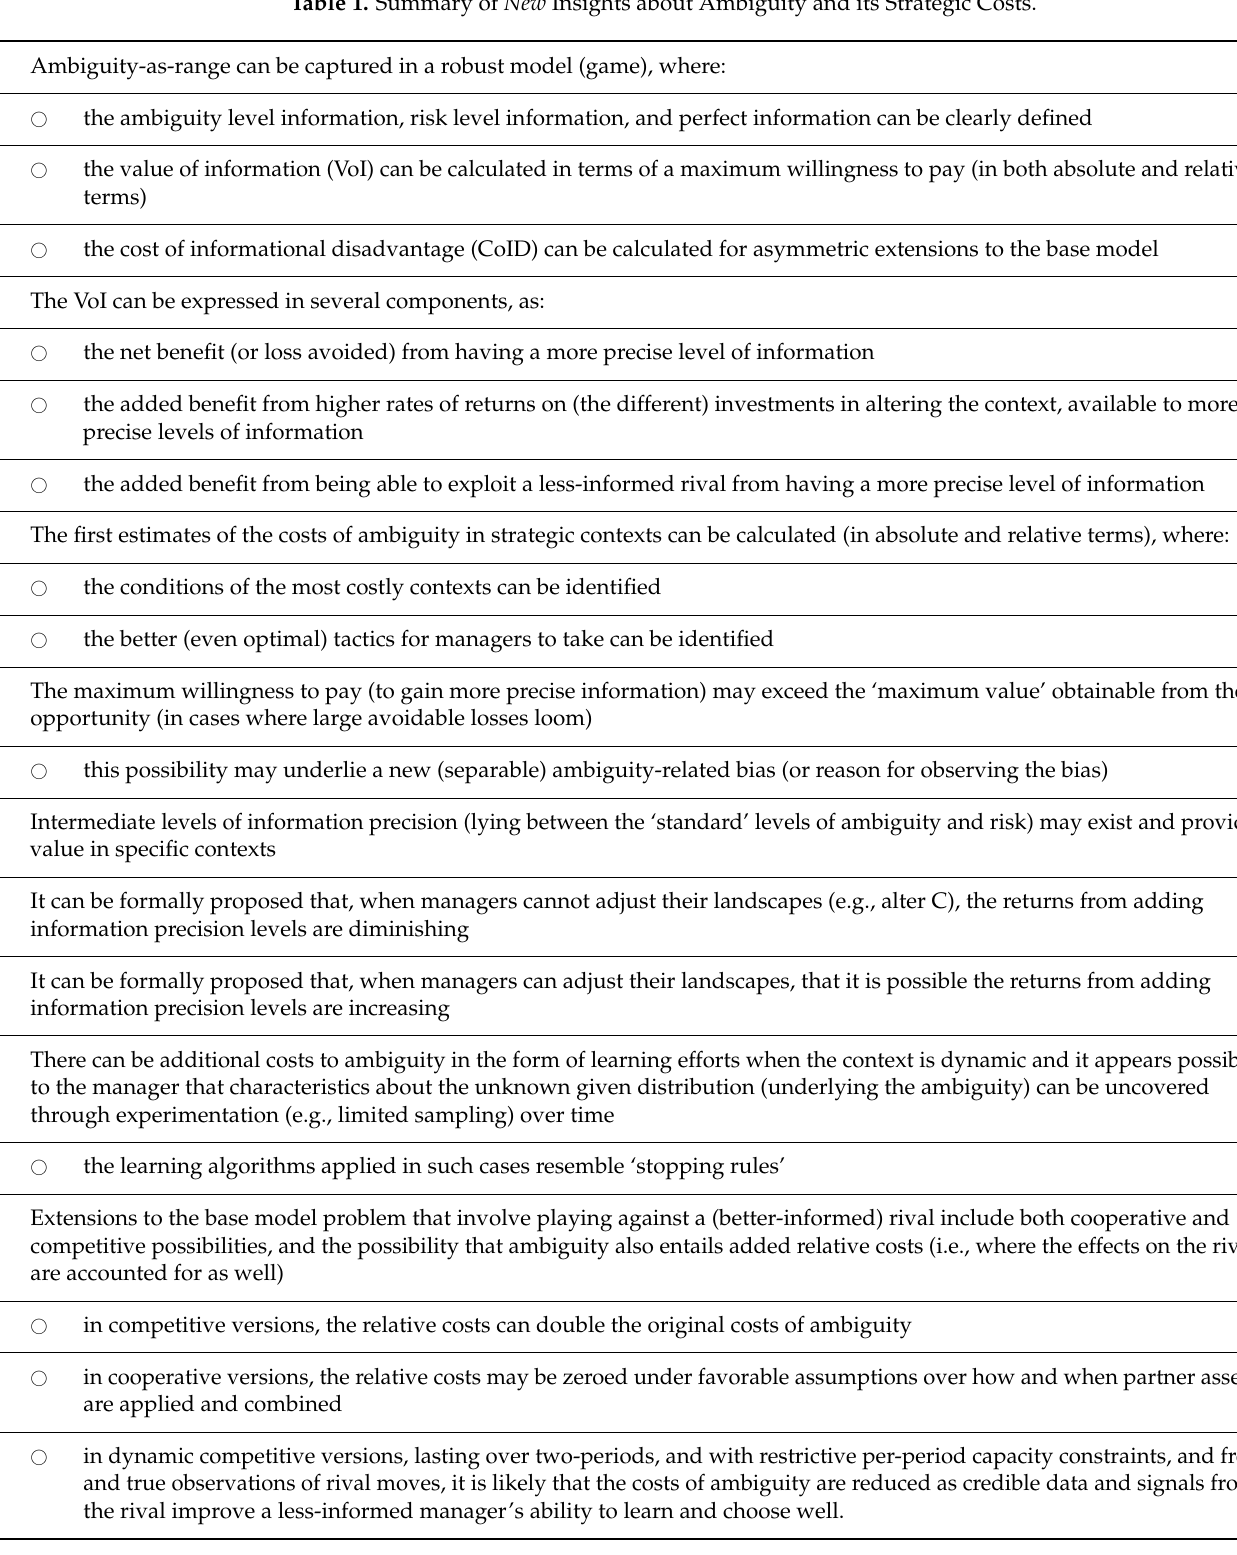
Table 1. Summary of New Insights about Ambiguity and its Strategic